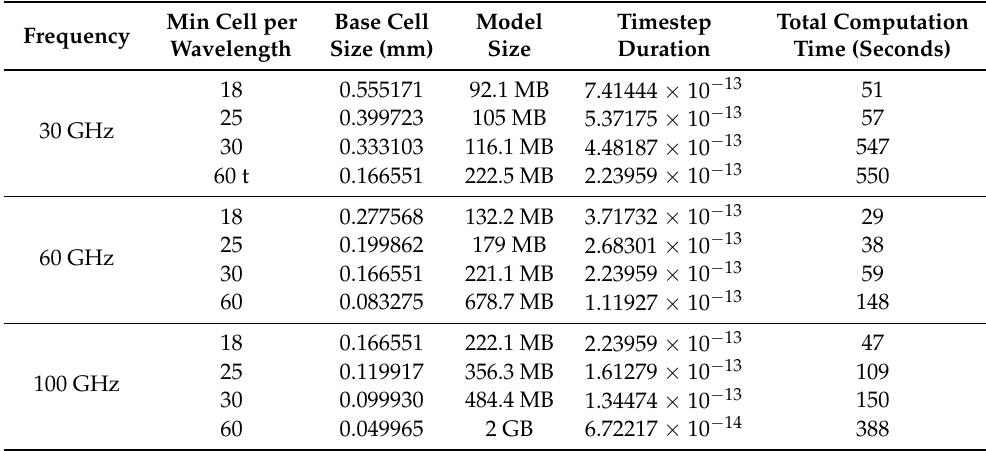
Table 3. The changes associated with variations in cell size and the computation time using manual cell size setup. The lower frequencies have a larger wavelength and for a given wavelength, the minimum cell per wavelength is larger in absolute terms.